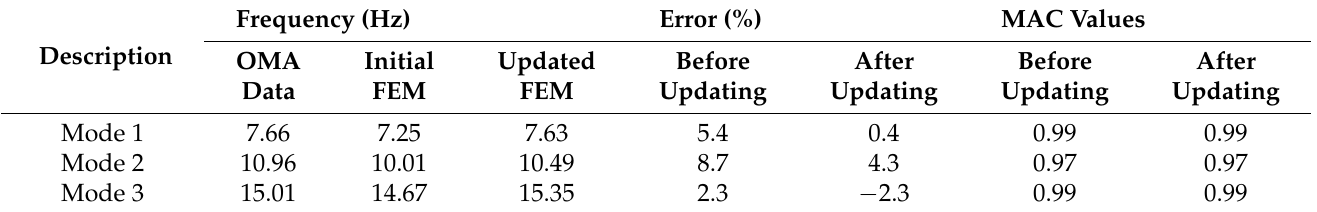
Table 4. Results of the modal analysis before and after updating.